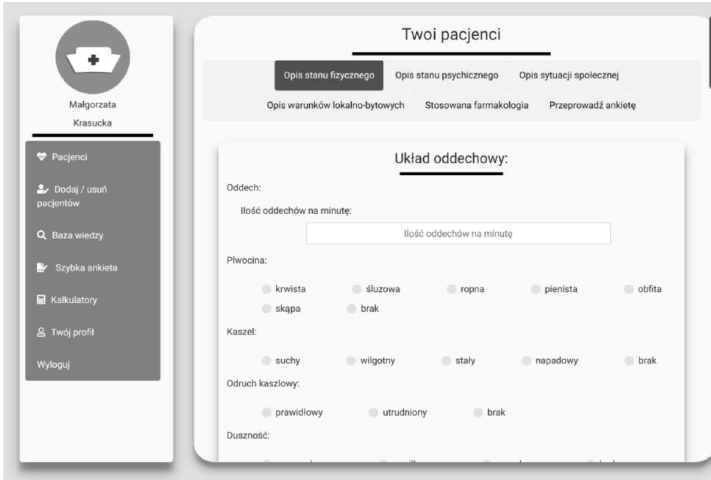
Figure 7. Appearance of the module for the description of a geriatric patient under long-term home care – part 1